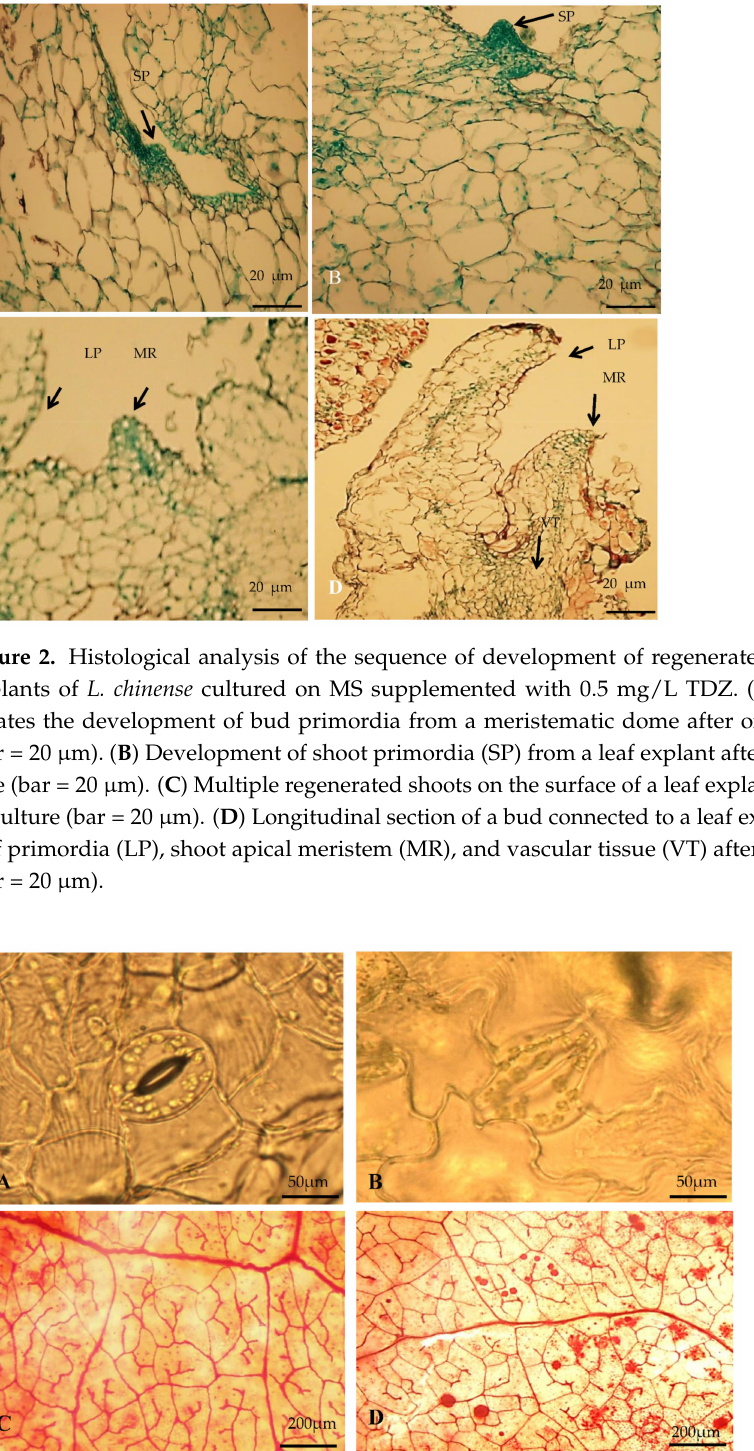
Figure 3. Foliar micromorphological studies of L. chinense . ( A ) Stomatal structure of regenerated plants (bar = 50 µ m), ( B ) mother plants (bar = 50 µ m), ( C ) Venation pattern in leaves of in regenerated plants (bar = 200 µ m), ( D ) mother plants (bar = 200 µ